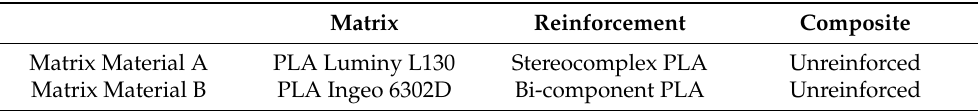
Table 1. Materials used in the study. The base matrices and the corresponding reinforcement for the bio-based polymer composite production. Both matrix materials are procured from Total Corbion [32] and NatureWorks [33],